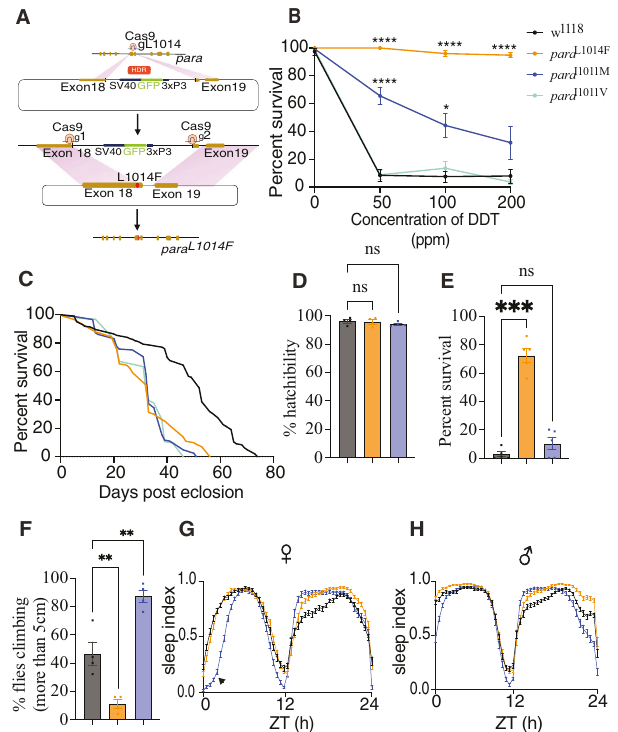
Fig. 1 kdr mutations para L1014F and para I1011M confer insecticide resistance in Drosophila melanogaster . A Generation of kdr mutations. First, a GFP transgene was inserted at the L1014 site using Cas9-mediated editing. Next, the GFP insertion was deleted with a pair of gRNAs cleaving adjacent sequences and replaced with a donor template containing one of the desired mutations (L1014F, I1011M or I1011V). Successful transformants were screened as GFP negative and later con fi rmed by genotyping. B DDT resistance: Flies (total number of fl ies n = 200; number of independent replicates N = 8) were exposed to different concentrations of DDT. Survival, a proxy for DDT resistance, was determined 24h post exposure. At the reference dose of 50 ppm DTT, the mean resistance values ± s.e.m were: WT = 8.4±4.3; L1014F = 100±0; I1011M = 65.6±6.15; I1011V = 8.75±3.6. C Survival plot for para WT (Median lifespan = 52), para L1014F (Median lifespan = 33), para I1011M (Median lifespan = 33), para I1011V (Median lifespan = 32) males in absence of any insecticide. All three mutants displayed shortened lifespans compared to the control. Data were analyzed using the Log-rank test for trend and the Mantel-Cox test. D Comparison of embryonic survival. No signi fi cant differences in hatching rate were observed among WT, para L1014F and para I1011M genotypes. N = 4; n = 400. E para L1014F are resistant to